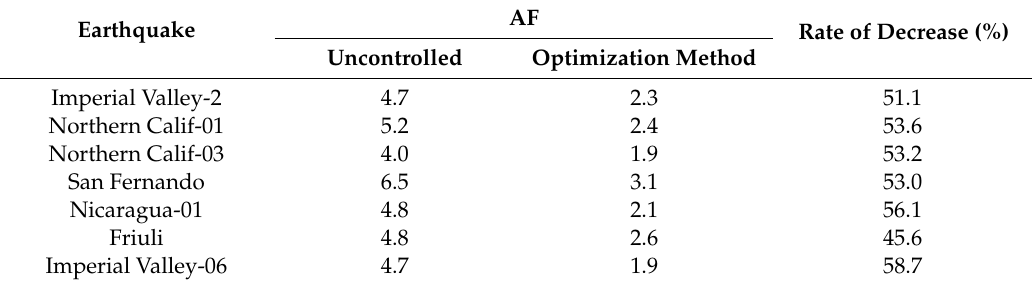
Table 9. AF and rate of decrease due to seismic loading of the electrical cabinet with and without a